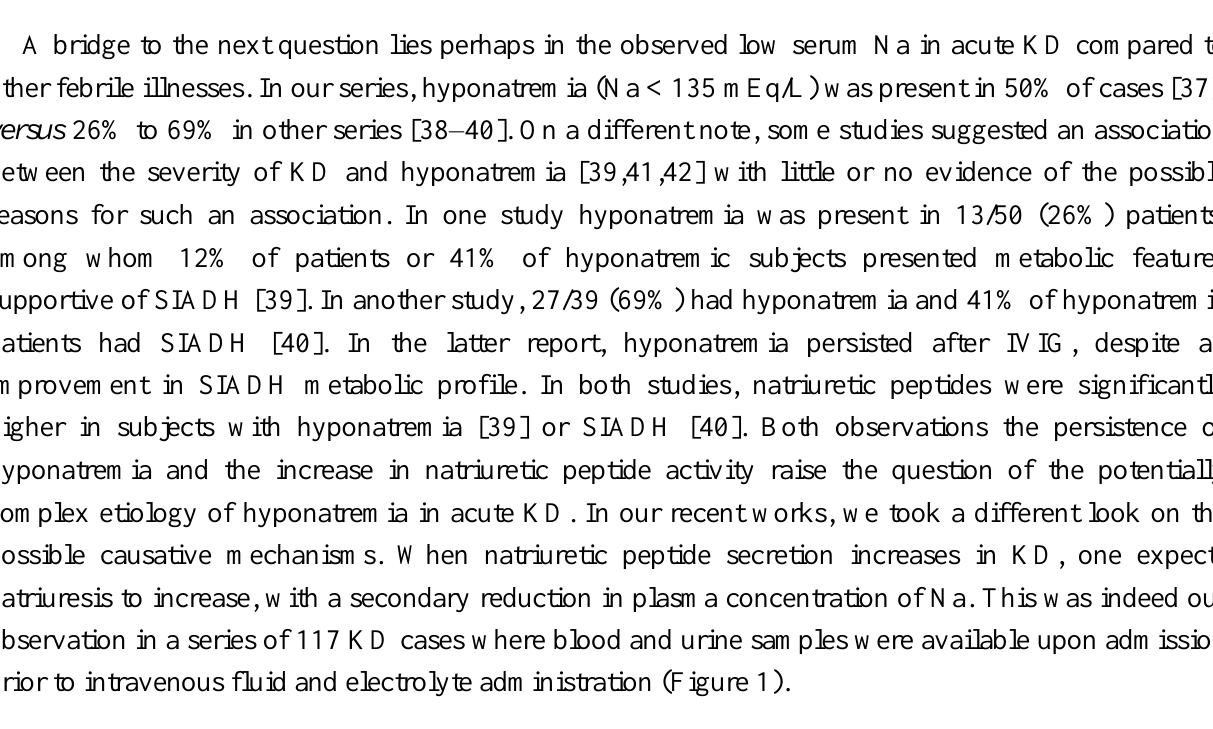
Figure 1. With higher serum NT-proBNP, there is lower serum sodium concentration (blue circles) concomitant with lower urine specific gravity (green triangles). This observation contradicts the theory of an increased antidiuretic hormone activity where an elevated specific gravity is expected with